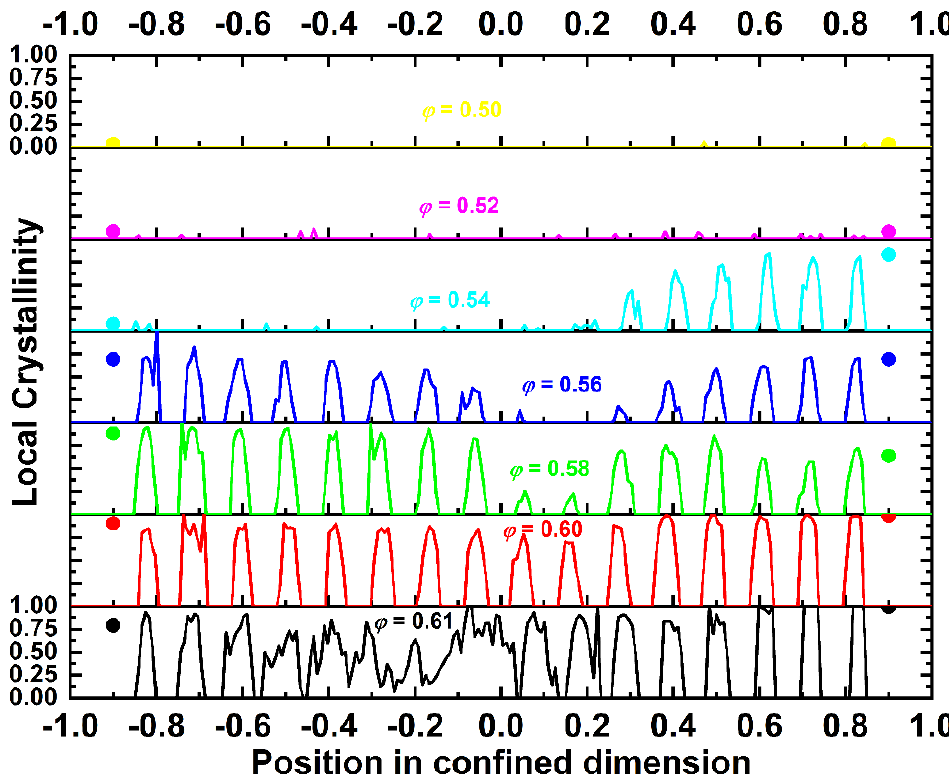
Figure 8. Stacked plots of the local crystallinity, as quantified by the CCE norm as a function of the position in the confined dimension for the N = 100 system. Different plots correspond to different packing densities. The lines and symbols correspond to the bulk and surface local crystallinities, respectively.